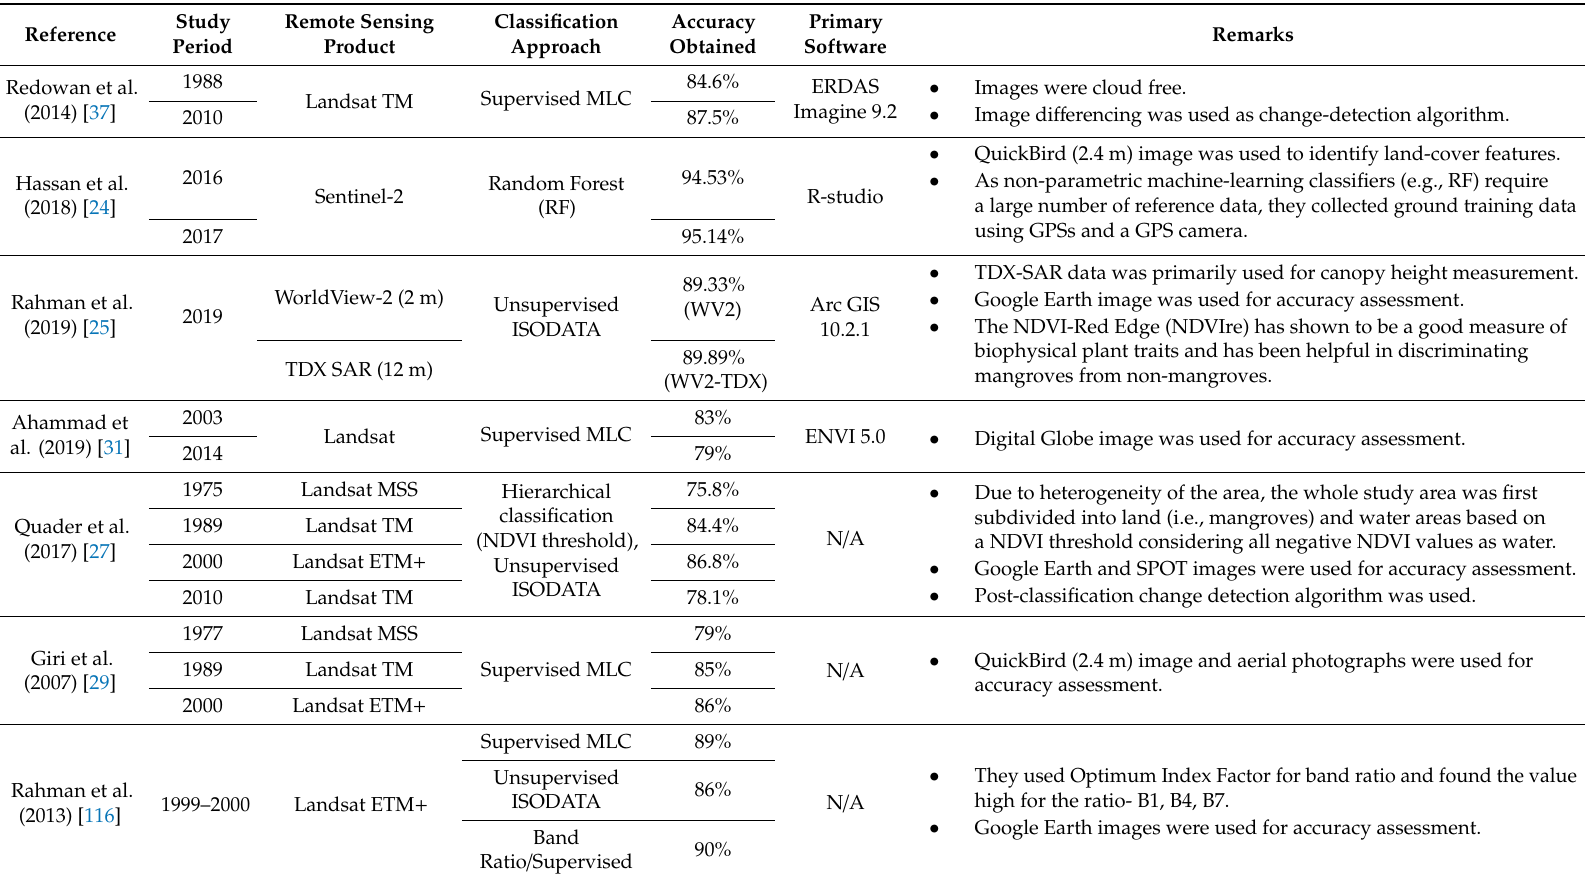
Table A2. Details of the forest-related remote-sensing studies that conducted forest cover